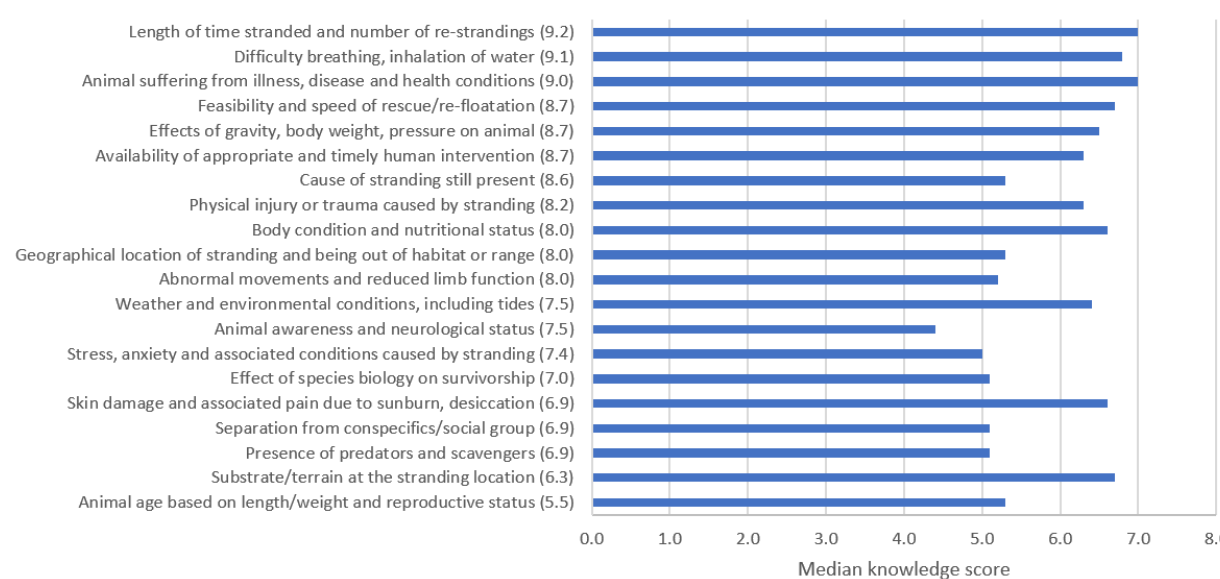
Figure 2. The median scores for the perceived level of knowledge available to assess concern categories about survival likelihood. Ranked in order of the median scores for the perceived severity of the effect of each concern category (in parentheses) on cetacean survival likelihood, arising from participants’ responses on questionnaire 2. Category labels have been reduced to best fit; please refer to Table 3 for full category labels.